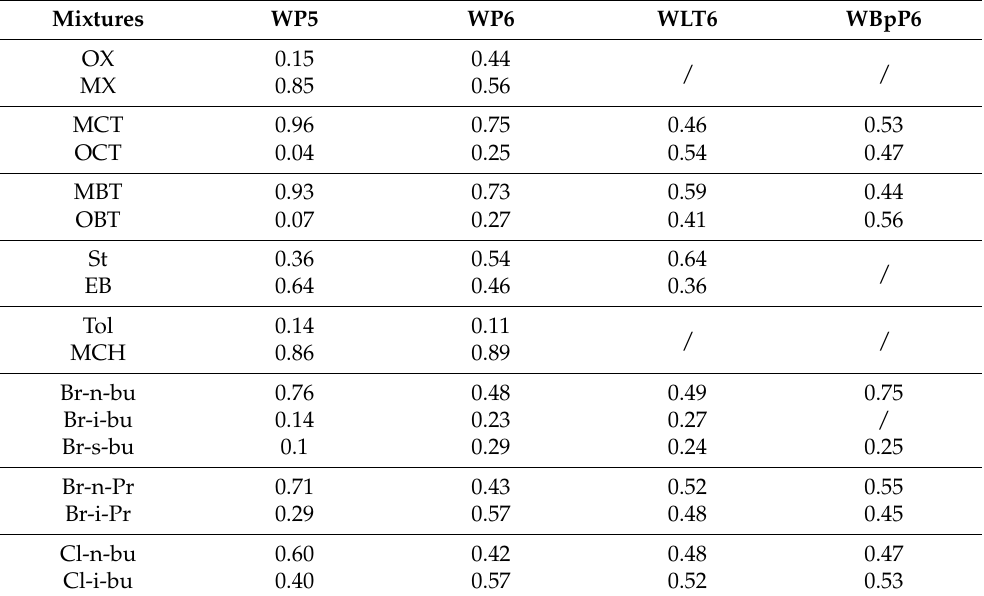
Table 1. Composition of extracts after extraction by four water-soluble pillararenes according to the re- sults of 1 H NMR